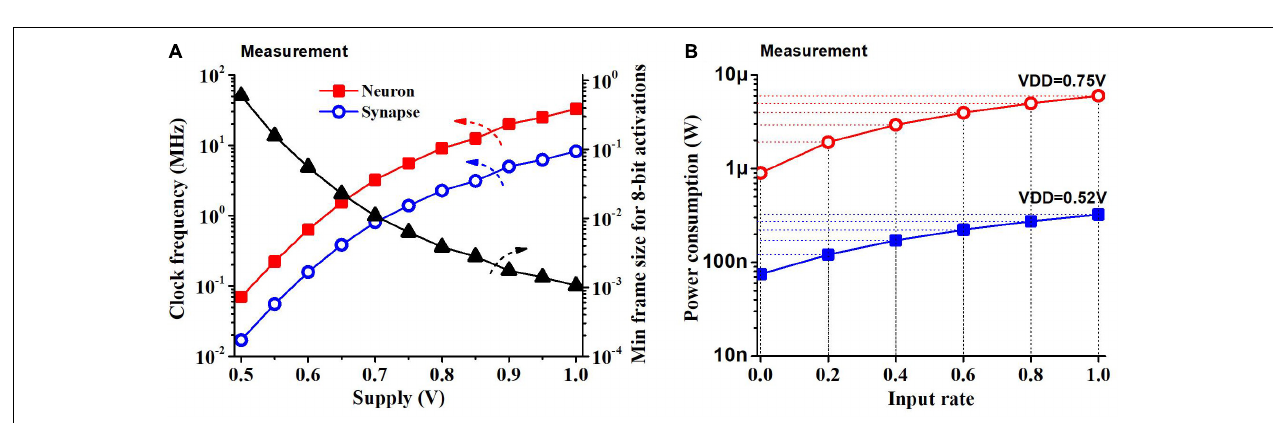
FIGURE 9 | (A) Die photo of the SNN Classifier with the Neurosynaptic Cores along with the Test Circuits. (B) Area break-down of the SNN Classifier. (C) Test chip with its connection to the FPGA board and LabVIEW. FPGA interface is used for sending the inputs to the chip and reading out the potential of the output neurons. LabVIEW is used for configuring the thresholds and write to the SRAMs.